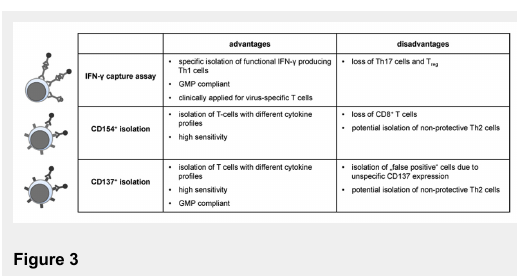
Advantages and disadvantages of different enrichment strategies for antigen-specific T cells. GMP = Good Manufacturing Practice; IFN =